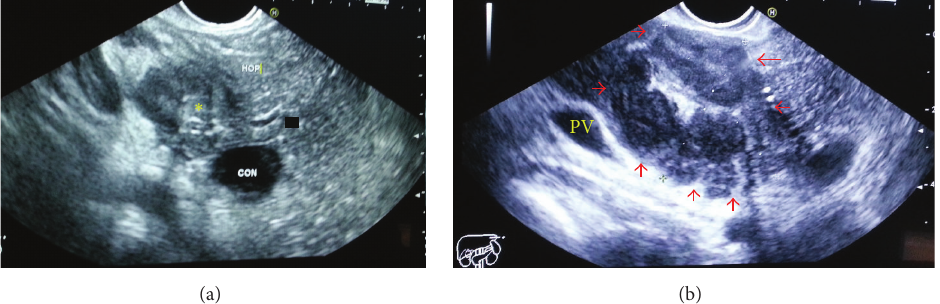
Figure 2: EUS showed a large hypoechoic mass mixed with hyperechoic spots and septate, measuring 4 × 4.7 cm, sets in the retropancreatic area with no fluid content noted with significant mass effect on the common bile duct. Superior mesenteric artery visualized and portal vain